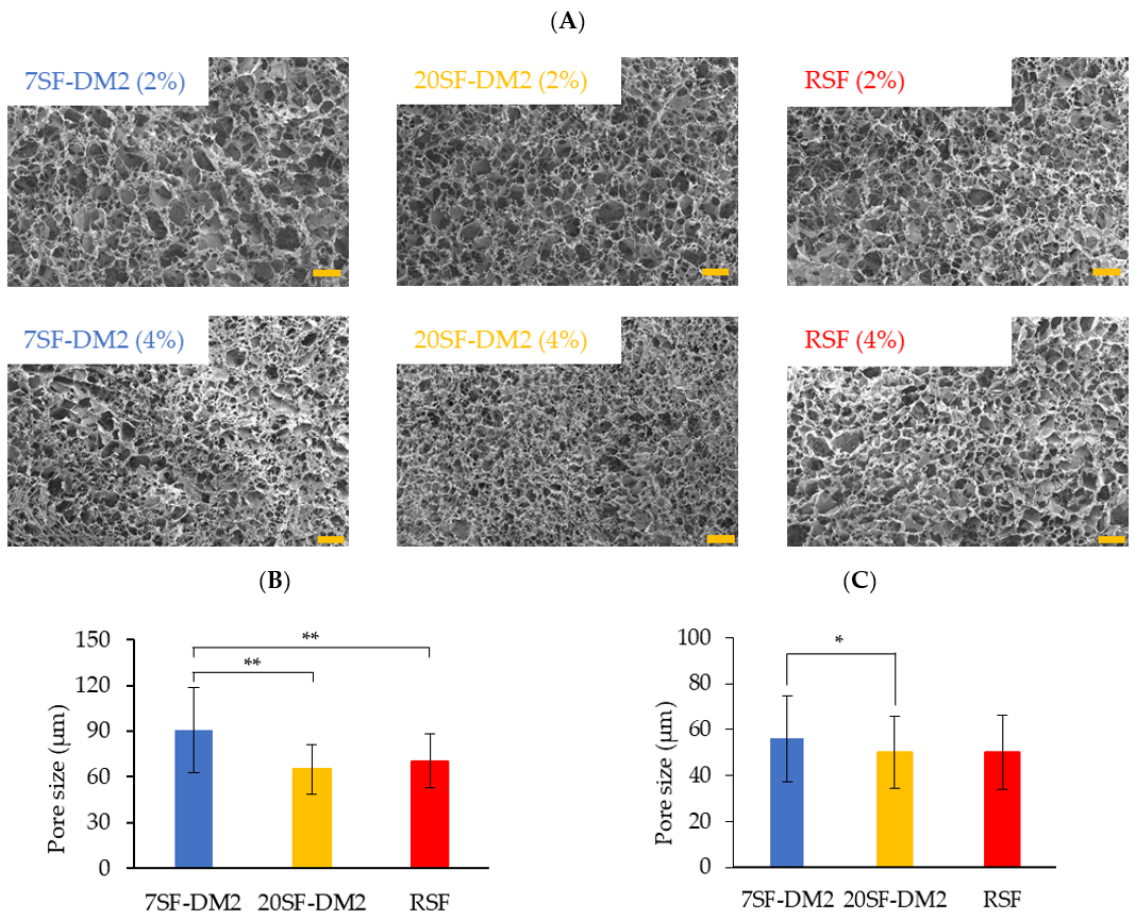
Figure 7. ( A ) SEM images of sponges fabricated from the fractionated SFs. Scale bar = 100 µ m. Significance was inferred from t -test results, shown as ** p < 0.01 and * p < 0.05 ( n = 50). Pore sizes of sponges fabricated at ( B ) 2% ( w / v ) and ( C ) 4% ( w / v ) of SF aqueous solution. Pore size was measured using Image J from SEM images.